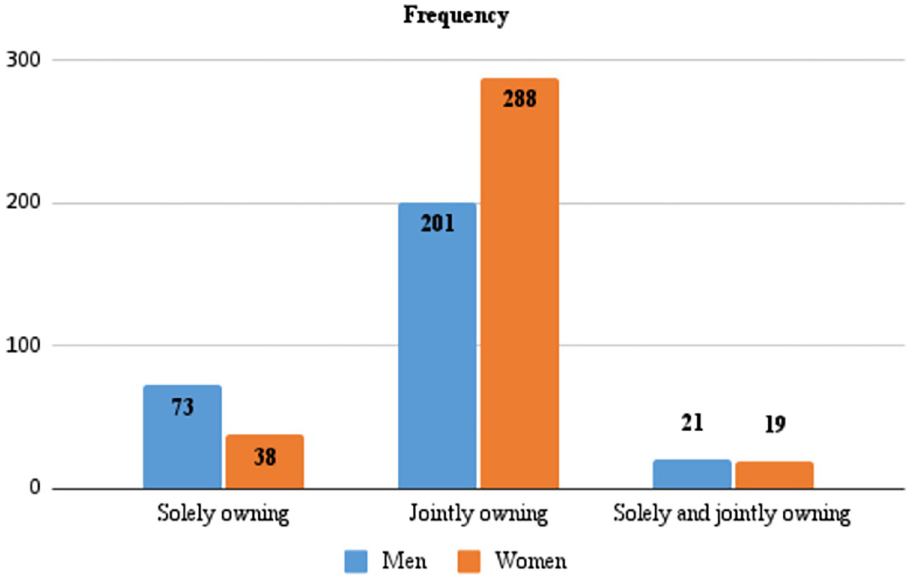
Fig 3. Ownership of small ruminants by gender at the household